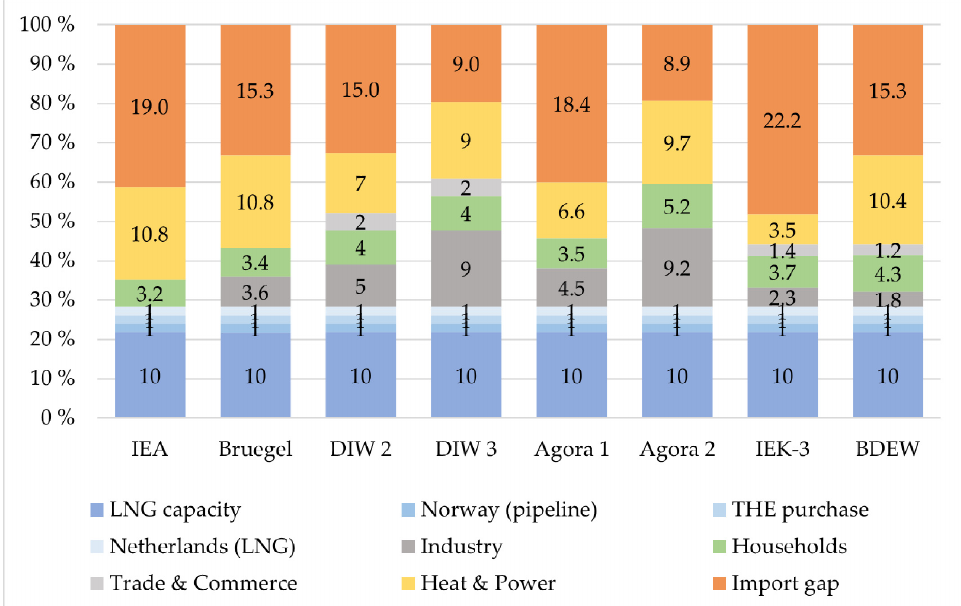
Figure 7. Import gap accounting for short-term gas availability (blue) and potentials for a demand decrease in consumption sectors. IEA refers to [86], Bruegel to [87], and DIW 2 and 3 refer to the medium and optimistic scenarios of [88], respectively. Agora 1 and 2 refer to the two scenarios of [42], IEK-3 refers to [41], and BDEW refers to [8]. Note that the contribution for households in [42] includes reductions for trade and commerce, while also [86,87] provide joint estimates for residential and commercial energy conservation, included in the household category above. Estimates by [86,87] are approximated by relating published contributions for the EU to Germany’s consumption share of 23%. Smaller contributions, such as from a ban of natural gas-fired cars, are not in- cluded.